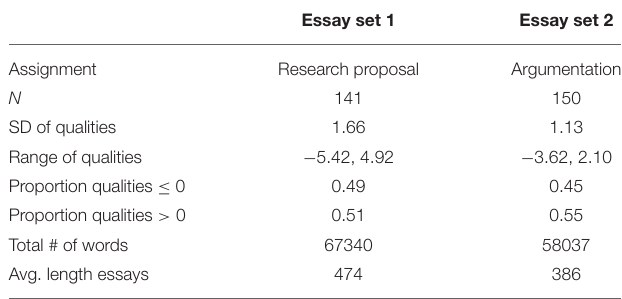
TABLE 1 | Description of the contents of two essay